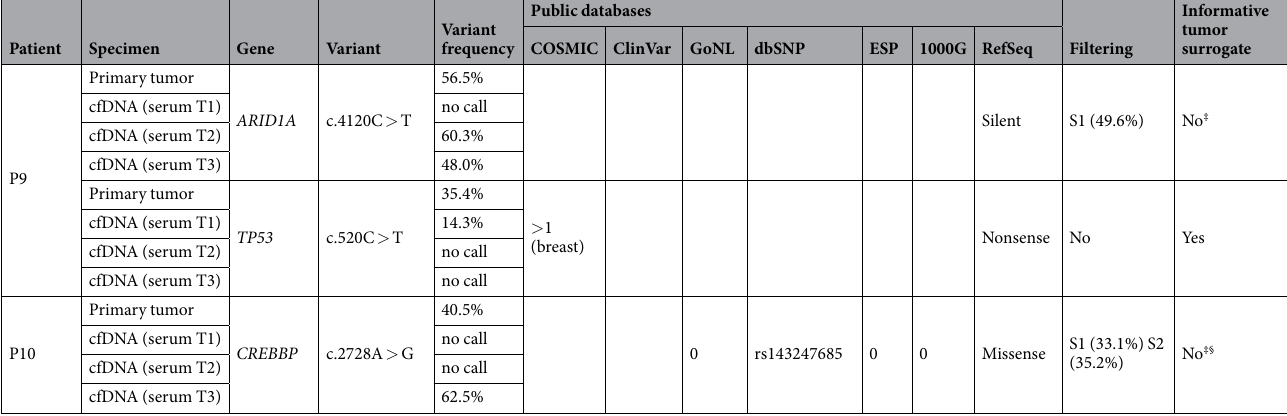
Table 1). Theoretically, polymerase introduced artefacts – with a mutation rate of high-fidelity polymerases in the order of one mutation per a million bases – can reach approximately 300 variants per targeted amplification (worst-case scenario with 21 PCR cycle amplification of a 139 bp amplicon). However, these randomly intro- duced artefacts should not exceed variant frequencies above 1.5% for minute quantities (a single artefact in 250 pg representing 36 diploid cells 20 ) and 0.05% for standard quantities (a single artefact in 10 ng representing 1429 diploid cells), which is both below the 2% threshold used by the variant caller. However, we did observe a larger variation in variant frequency when using only minute input amounts for the primary tumor minute replicates (Supplementary Figure S3A) and also for the cfDNA samples (Supplementary Figure S3B). Amplification bias and variability in length of the fragmented DNA might skew the amplification of specific DNA fragments and thus variant frequency of detected variants 21 . We were unable to discover the exact reason why an increase in detected variants occurred in a few samples, and thus confirmation of detected variants is necessary. Commonly, valida- tion of variants is achieved by independent re-analysis of the DNA sample. However, in retrospective cohorts this is not always possible due to restrictive sources of DNA. As an alternative, we suggest the confirmation of variants through the detection in at least two DNA samples of an individual patient. Because our cfDNA samples originate from consecutive serum draws, this means we might miss variants such as those occurring only during a specific stage in the disease trajectory. Also, we are aware that an obvious drawback of using only minute quantities of cfDNA is false negative detection. We can expect variants – especially low frequent variants – to be missed just by chance because of using minute fractions representing forty times fewer molecules than the standard input. Thus, we were able to detect multiple putative somatic variants in primary tumor material as well as their corresponding serum-derived cfDNA samples. As a final step, we further inspected these variants whether they truly represent informative tumor surrogates. First, we compared variant frequency between patient-matched samples. The fraction of tumor-derived cfDNA is expected to be only a few percentages 22 , whereas the primary tumor specimens are expected to have high tumor cell content. Therefore, somatic variants at around 50% variant frequency in both the primary tumor as well as the cfDNA are likely heterozygous SNPs; somatic variants at a low variant frequency in both the primary tumor as well as the cfDNA are potential artefacts. Somatic variants with a clearly different variant frequency between the primary tumor and cfDNA, or between consecutive cfDNA draws at different disease stages (e.g. disease recurrence), are indicative for true somatic variants traceable as ctDNA. Second, we took an advantage of public databases on variants. However, we observe conflicting annotation, i.e. variants being reported as both germline SNP but also as a tumor-specific somatic mutation in public databases (Table 3). Thus, this information should be taken with caution. Third, we verified if – due to stringent threshold settings – the detected variants had not been filtered out in patient-matched samples. Based on these three aspects we defined if the variant detected in cfDNA are to be used as an informative tumor surrogate (Table 3). A limitation by using only minute quantities of cfDNA is the detection limit in the order of 2% variant fre- quency (250 pg represents approximately 36 diploid cells 20 thus allowing the detection of 1 mutant copy in 72 wildtype copies), whereas tumor-specific cfDNA can be present at variant frequencies as low as 0.001% 22 . Also, the retrospective serum samples used in this study are likely contaminated with DNA from non-tumor cells such as lysed leukocytes 23 , and thus the fraction of tumor-derived cfDNA is expected to be low. We are aware that the preservative in the blood collection tube (i.e. cloth activator or anti-coagulant), and processing procedure of the blood-derivative (i.e. time-to-processing and sedimentation speed), has a great influence on the cfDNA quantity 24–27 , and because this affects the fraction of tumor-derived cfDNA it should be kept in mind when